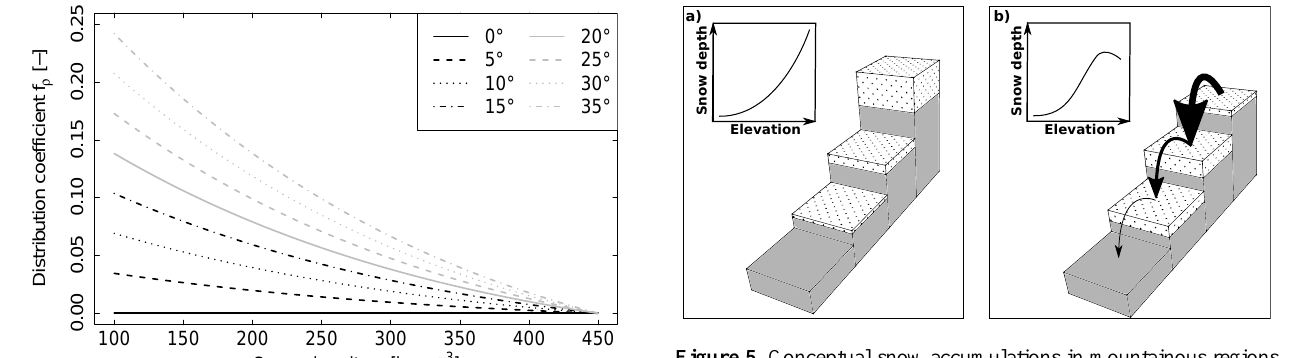
Figure 5. Conceptual snow accumulations in mountainous regions without (a) and with (b) lateral snow transport processes. Dotted blocks represent exaggerated snow